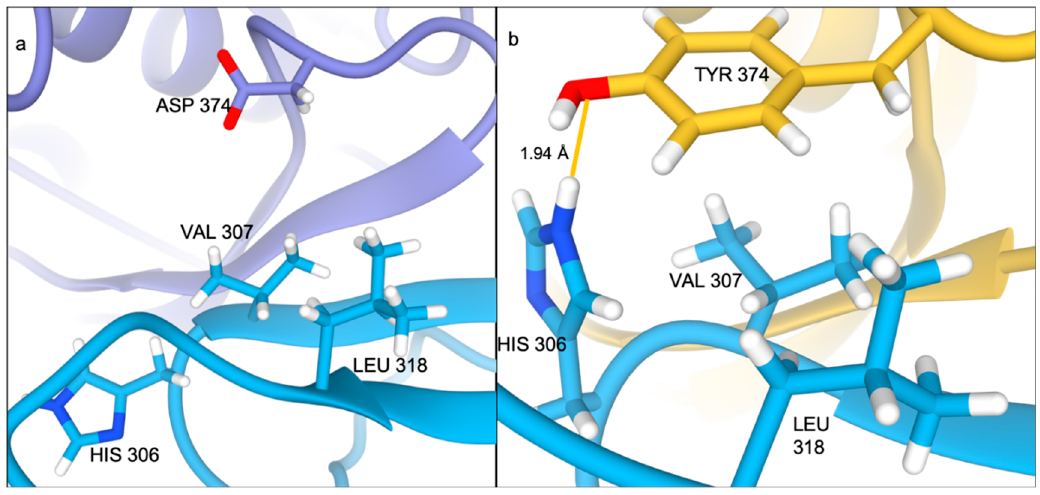
Figure 5. Interface of the ( a ) wild-type and ( b ) Asp374Tyr mutant at the PCSK9 catalytic domain / LDLR interface after 500ns of MD simulation.